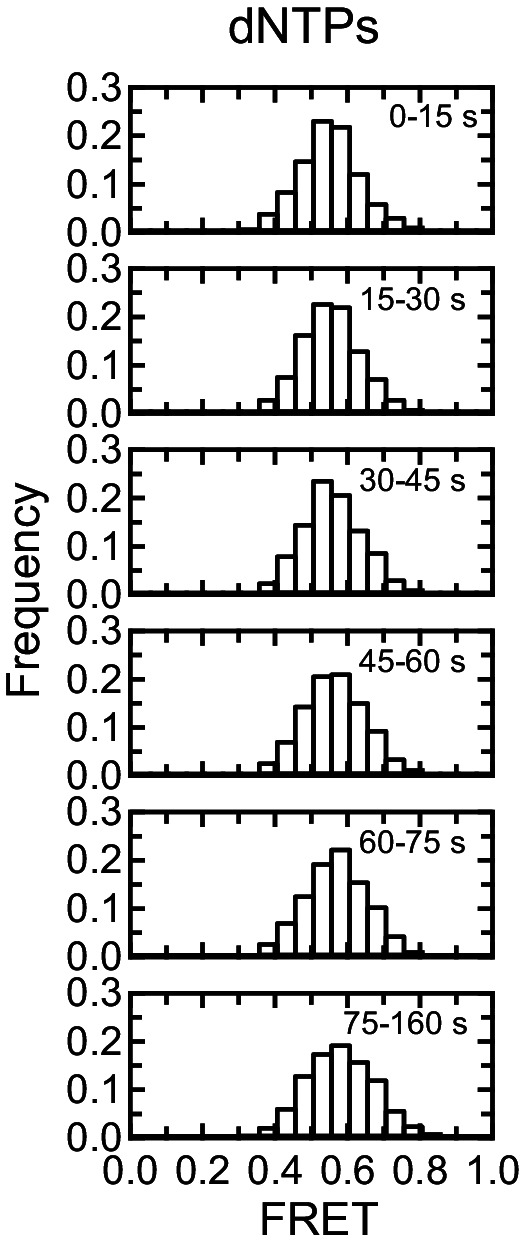
Control for effect of dNTPs on F-[7GGT]4 FRET.Histograms showing changes in FRET values of a population of F-[7GGT]4 molecules in the presence of dNTPs but absence of telomerase over 150 s, binned into 15–85 s time intervals. n = 110 molecules.